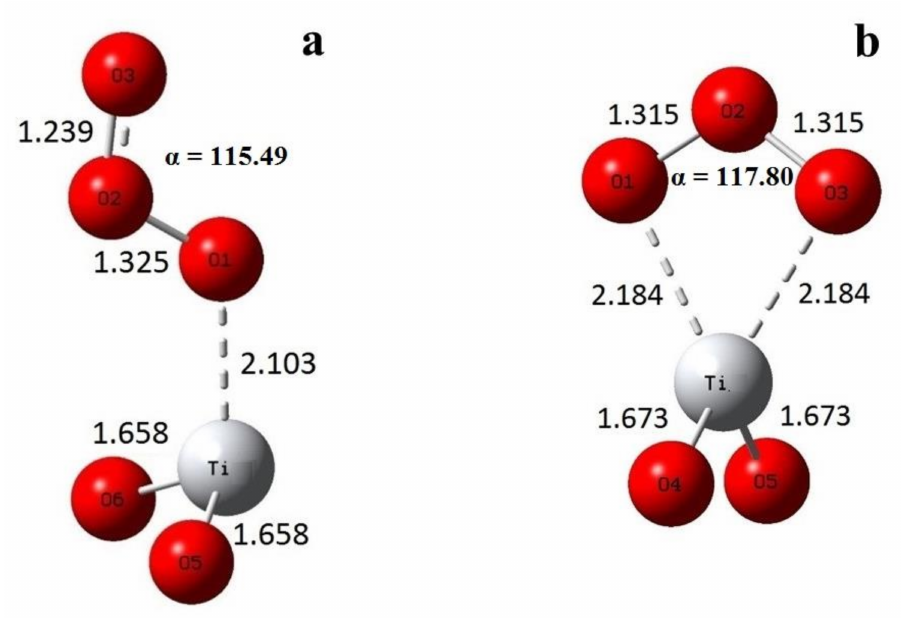
Figure 3. Optimized geometry of ( a ) monodentate (symmetry C s ) and ( b ) bidentate (symmetry C 2v ) ozone complexes with TiO 2 .